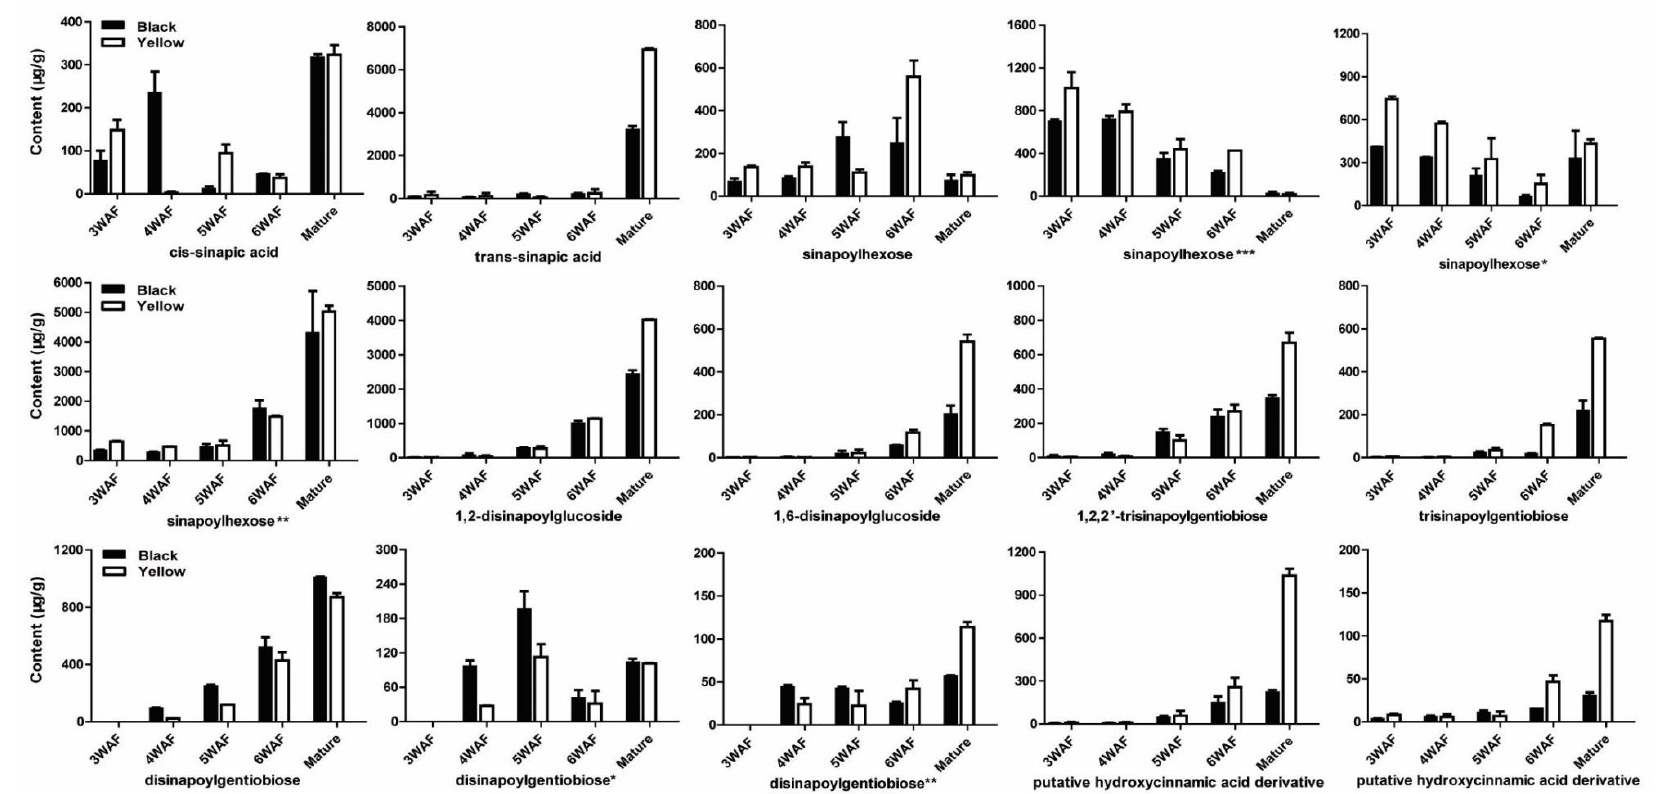
Figure 3. Accumulation pattern of hydroxycinnamic acid derivatives in yellow and black rapeseed. WAF, week after flowering.